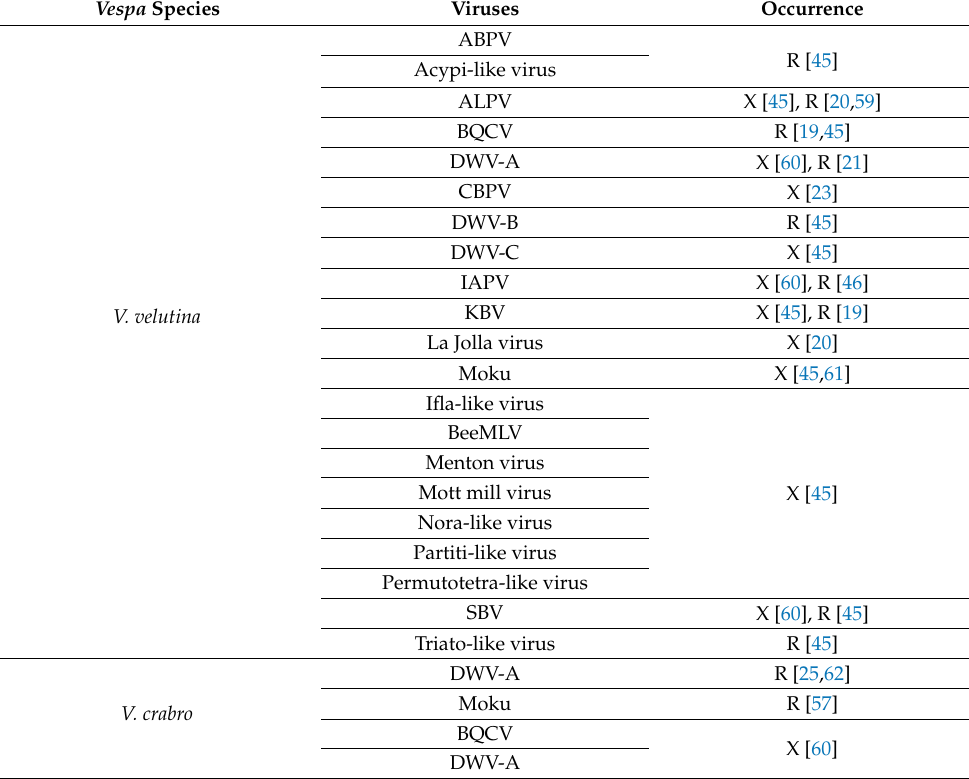
Table 1. Occurrence of viruses in Vespa